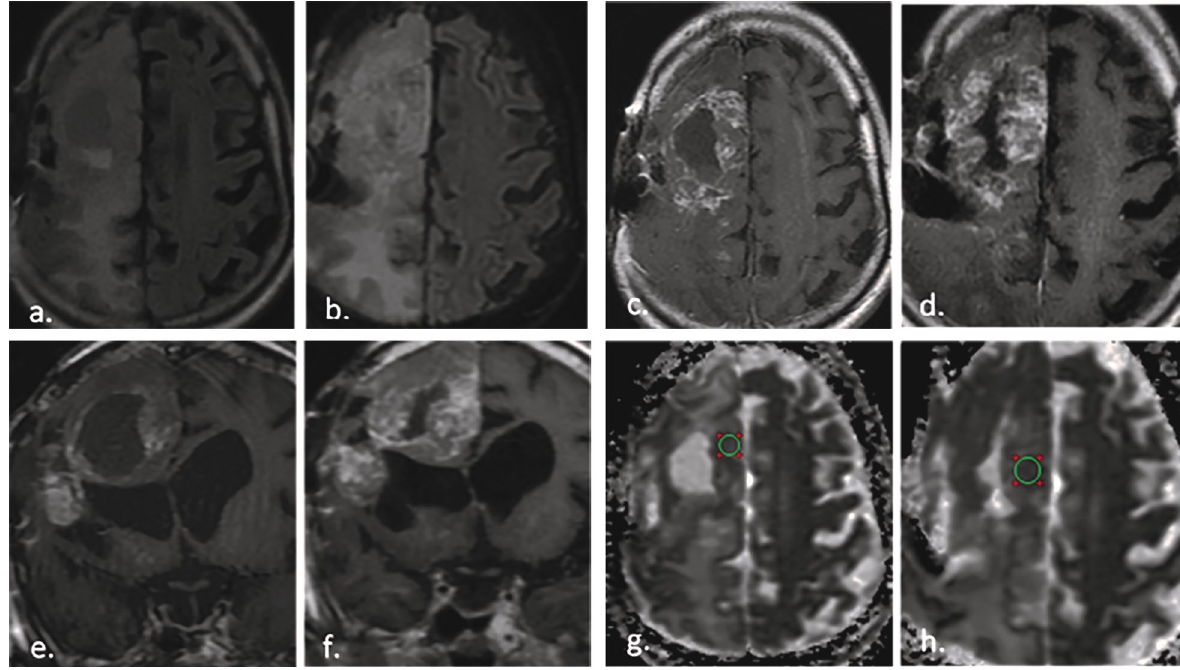
Fig. 3 A 44-year-old clinically-stable male patient with an operated right parieto-frontal grade III astrocytoma finished chemoradiotherapy 6 months ago. a and b Axial FLAIR images of the first and second studies, respectively show stationary size of the FLAIR component with development of a higher signal in the resection cavity in the follow-up study. No significant changes in the surrounding mass effect. c and d Axial post-contrast T1 WIs of the first and second studies, respectively show an increase in the enhancing component by less than 25% in the follow-up study. e and f Coronal post-contrast T1 WIs of the first and second studies, respectively show an increase in the enhancing component. g and h Axial ADC maps show a decrease of ADCmean in the enhancing resection cavity margin (1.1 FLAIR signal within resection cavity favor the possibility of tumor recurrence. Tumor progression was proved in the second stage follow-up